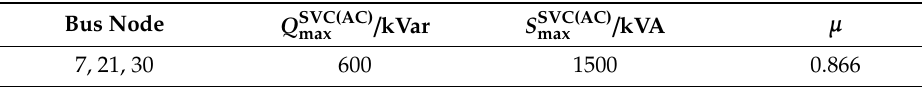
Table 3. Parameters ofvoltage source converter.